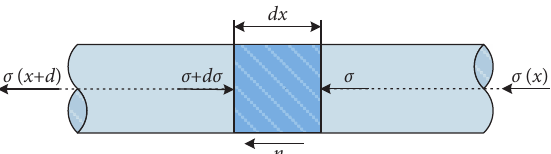
Figure 5: The drilling tool impact stress transmission diagram.